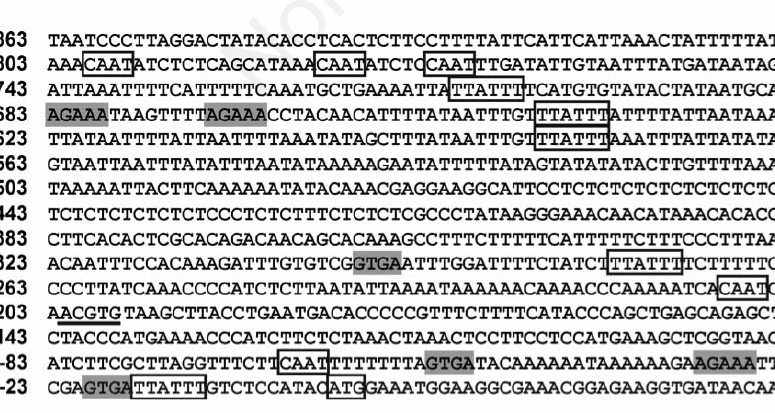
Figure 1. Nucleotide sequence of RcDREB1 promoter. Numbering is from the first base of translation start site (+1). Putative TATA, CAAT boxes and the translation start point ATG are shown in rectangular boxes. Pollen-specific cis -elements (AGAAA and GTGA) (gray background) and erd1 (early response to dehydration element) (underlined) are denoted.